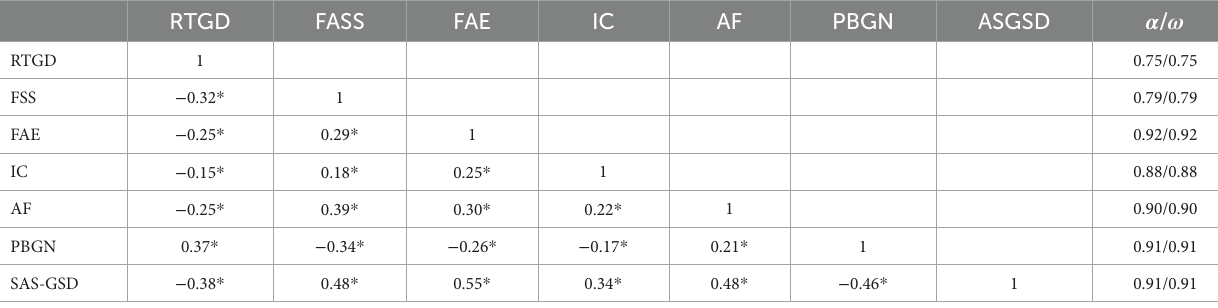
TABLE 2 Bivariate zero-order correlations between the seven factors of the gender climate